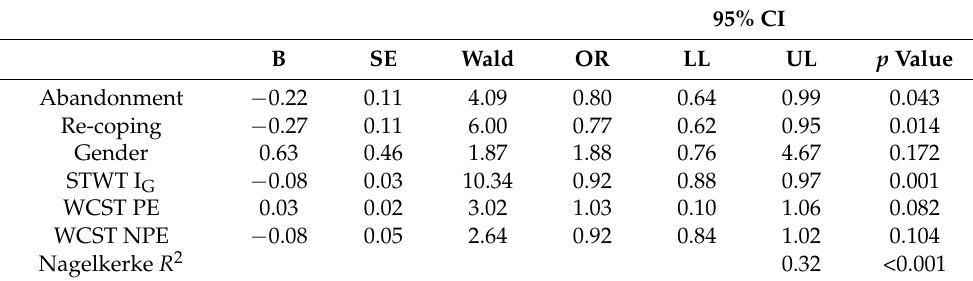
Table 2. Logistic regression analysis on